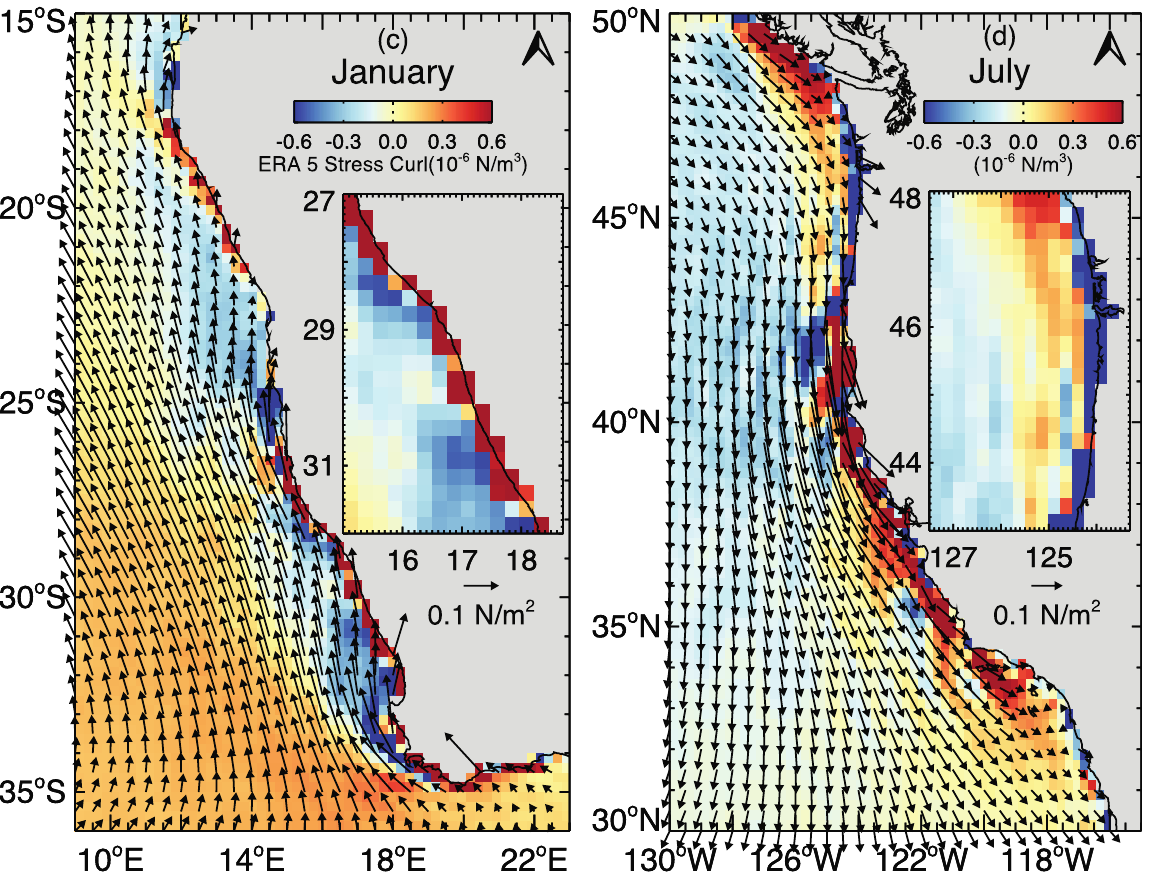
Figure 1. (Previous page) 10-year averages (11/1999-11/2009) of QuikSCAT v4.1 wind stress vectors (subset to 0.4 ◦ ) overlaid on wind stress curl (full 0.1 ◦ grid) for summer along the coasts of ( a ) southern Africa and ( b ) western North America. All L2B retrievals are used to create the 0.1 ◦ gridded values. (This page) 10-year averages (QuikSCAT period) of ERA-5 reanalysis wind stress vectors (subset to 0.5 ◦ ) overlaid on wind stress curl (full 0.25 ◦ grid) for summer along the coasts of ( c ) southern Africa and ( d ) western North America. From the interpolated 0.25 ◦ ERA-5 wind stress grid. The insets show expanded views of the reversal in sign of the wind stress curl next to the coast.